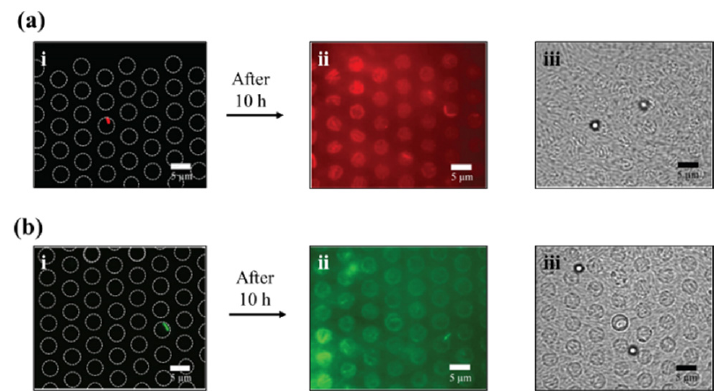
Figure 6. OT-mediated relocation of MB-SB from a µ w P to a µ w s array for bacteria growth under LB-agar patch. ( a-i ) Fluorescence image of µ w s array with mCherry-expressing bacteria on MB at 0 h, ( a-ii ) and at 10 h. ( a-iii ) Brightfield image of µ w s array with mCherry-expressing bacteria on MB. ( b-i ) Fluorescence image of µ w s array with GFP-expressing bacteria on MB at 0 h, ( b-ii ) and at 10 h. ( b-iii ) Brightfield image of µ w s array with GFP-expressing bacteria on MB. Single MB carrying mCherry-expressing ( a ) and GFP-expressing ( b ) bacteria were relocated to a µ w s array ( a-i and b-i , respectively), and incubated under a LB-agar patch for proliferation. Fluorescence (ii) and brightfield (iii) images taken after 10 h demonstrated successful, confluent bacterial growth in both the relocated mCherry- and GFP-expressing bacteria. The white dots seen in ( a-iii ) and ( b-iii ) are the MBs, from relocated MB-SB, under brightfield.